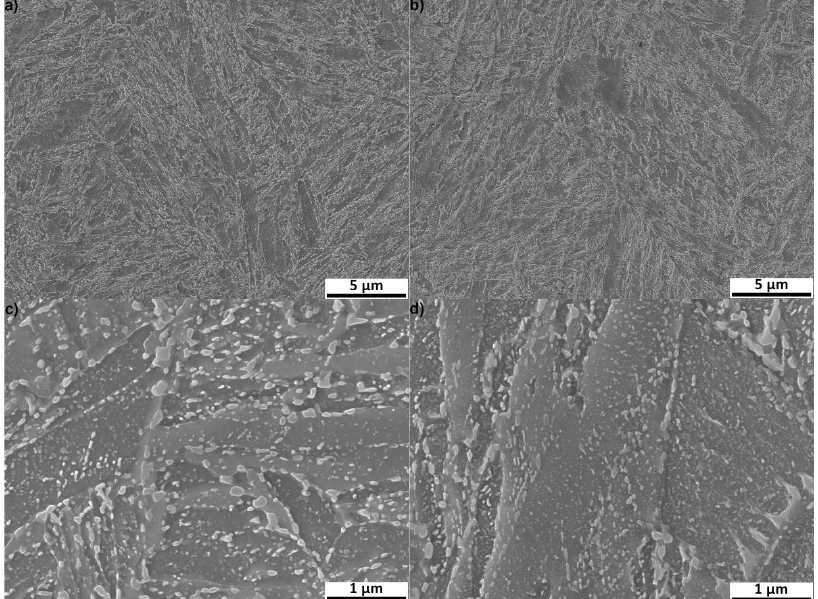
Figure 4. SEM-SE micrographs of samples 0 Cu tempered for 6 h ( a ); 1.5 Cu tempered for 6 h ( b ); 0 Cu sample tempered for 24 h ( c ); and 1.5 Cu sample tempered for 24 h ( d ). TEM was used for more detailed observation and analysis of the particles. The pre- cipitates were compared in both materials after tempering at 500 °C for 24 h. In both ma- terials, the large precipitates with a size of 50 – 200 nm occurred at the PAGBs and bound- aries of martensite packets (Figure 5a,b). Cementite particles were identified using se- lected area electron diffraction (SAED), as shown in Figure 5c,d.